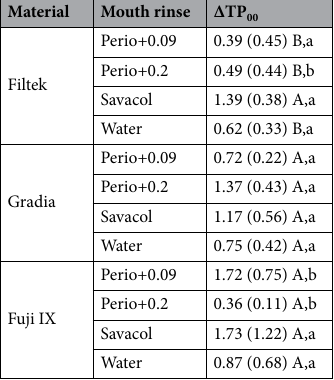
Table 3. Mean (SD) values of translucency parameter differences (ΔTP 00 ) after 28 days of exposure to mouth rinses. Upper case letters—columns comparing mouth rinses within each material. Lower case letters— columns comparing materials within each mouth rinse.